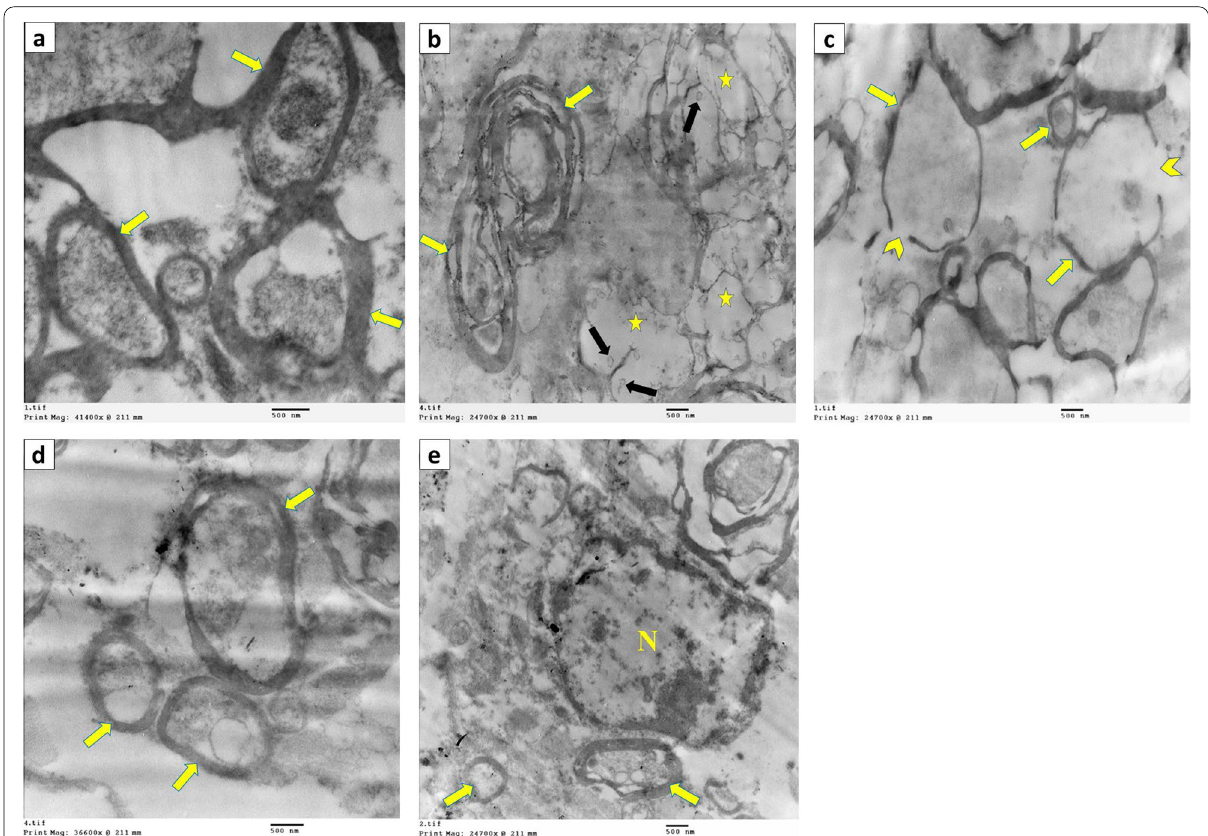
Fig. 7 Electron micrograph of the spinal cord sections demonstrating a control group with intact dense compact myelin sheath (arrow) ( × 20,000). b , c EB-treated group b exhibiting areas of demyelination and axonal swelling (star), degenerated mitochondria with complete loss of cristae (black arrow). Moreover, the splitting of myelin lamellae giving an onion-like appearance with shrunken atrophied axons is obvious (yellow arrow) ( 10,000). c Some nerve fibers reveal thin (arrow) interrupted (chevron) myelin sheaths ( 10,000). d , e PRP co-treated group d × × displaying reconstructed structure with regular more compact and thicker myelin sheaths (arrow) ( 15,000) and e Showing oligodendrocyte with × euchromatic nucleus (N) and high capacity of remyelination (arrow) ( ×